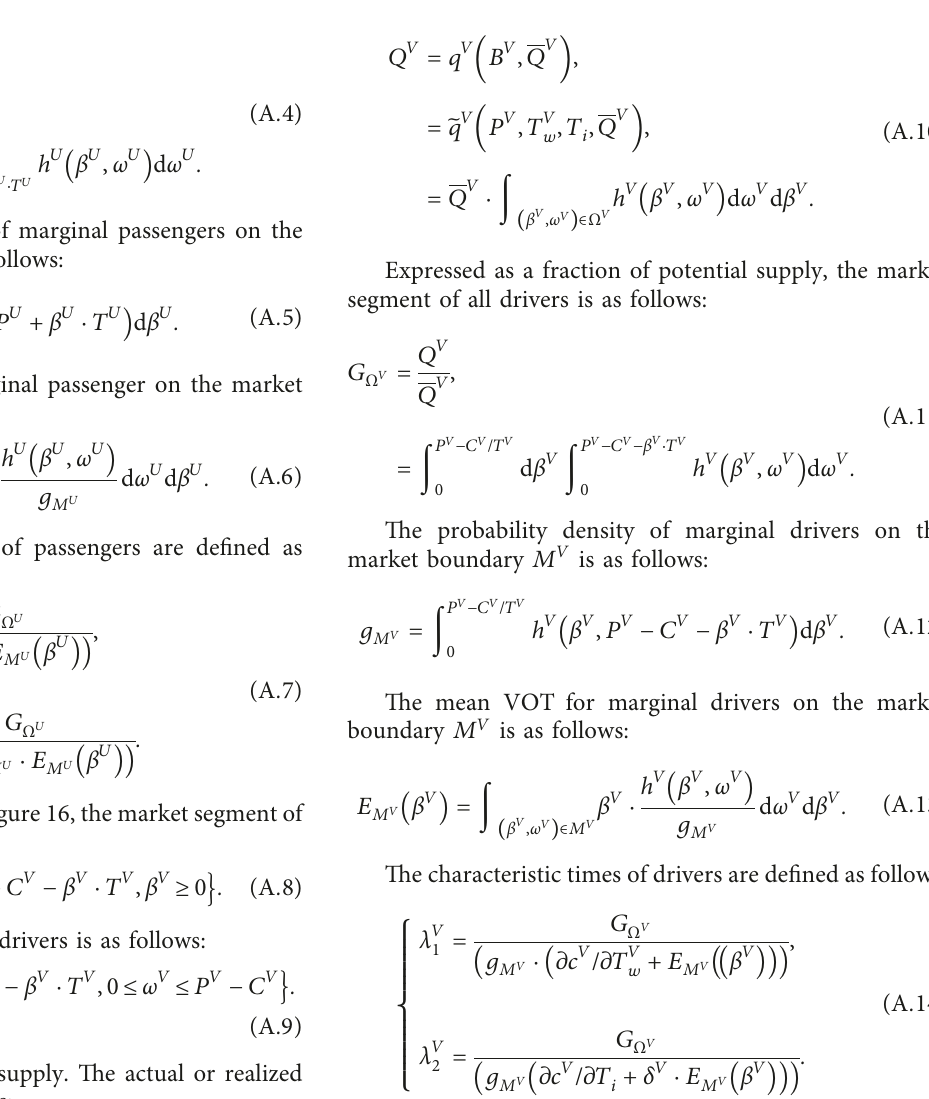
Figure 16: Heterogeneous user characteristics. (a) Passengers’ market segment and market boundary. (b) Drivers’ market segment and market